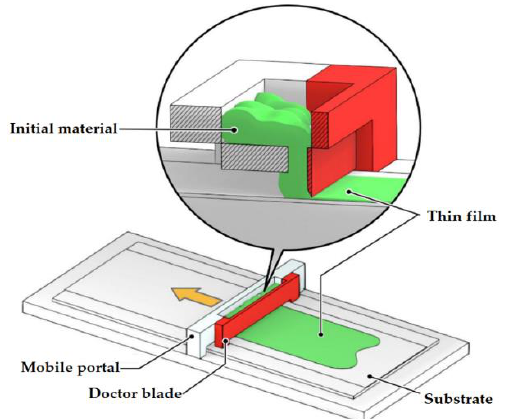
Figure 1. Material extrusion. Fabrication of a thin HEM film using the Doctor Blade Casting method .